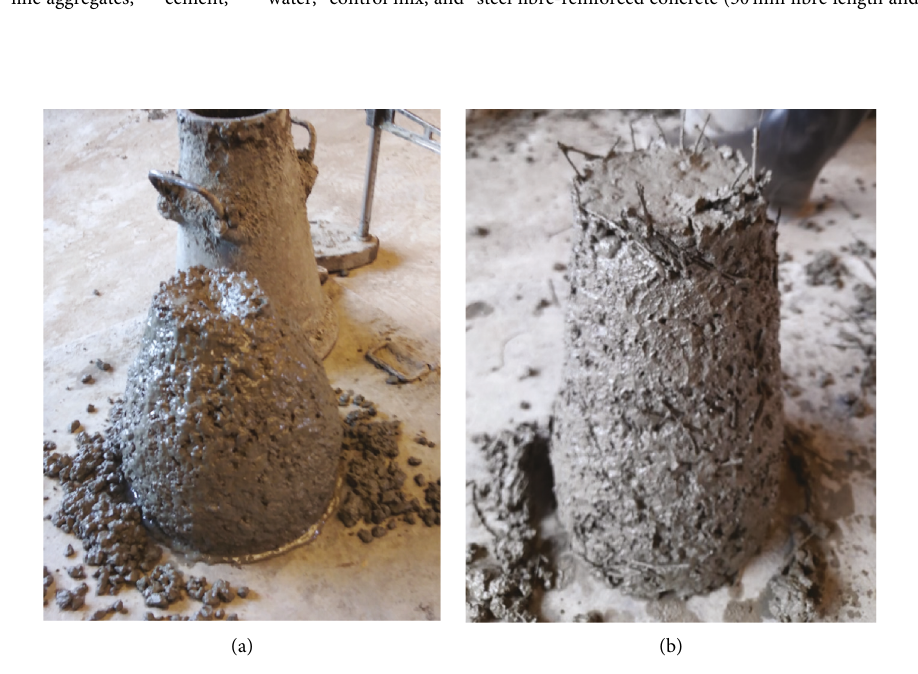
Figure 4: Concrete workability. (a) 90-mm slump for CM. (b) 20mm slump for SFRC60-1.0.